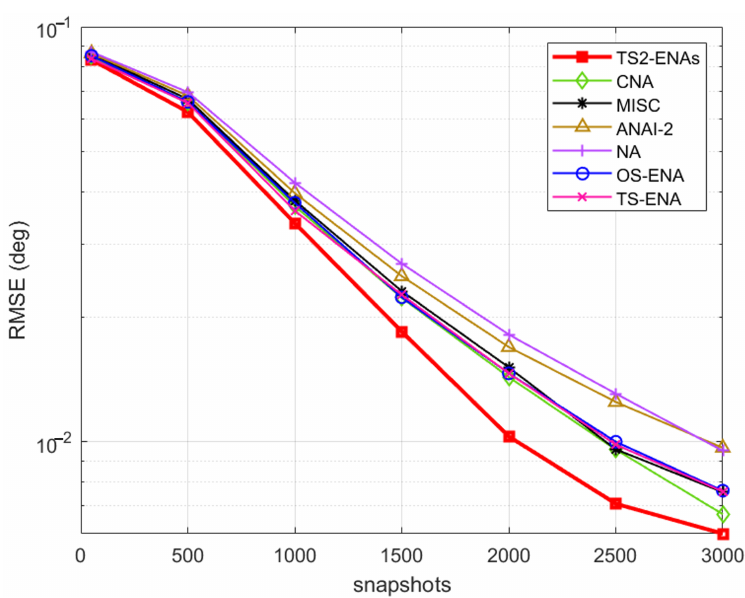
Figure 10. RMSE vs.